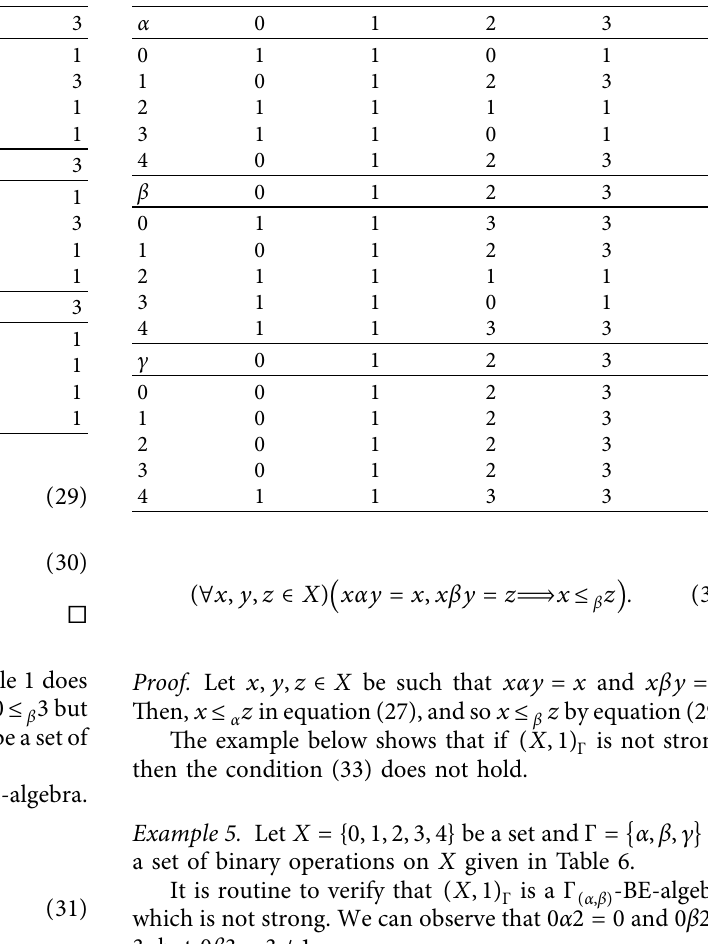
Table 5: Cayley tables for the binary operations “ α , β , and c .” Table 6: Cayley tables for the binary operations “ α , β , and c